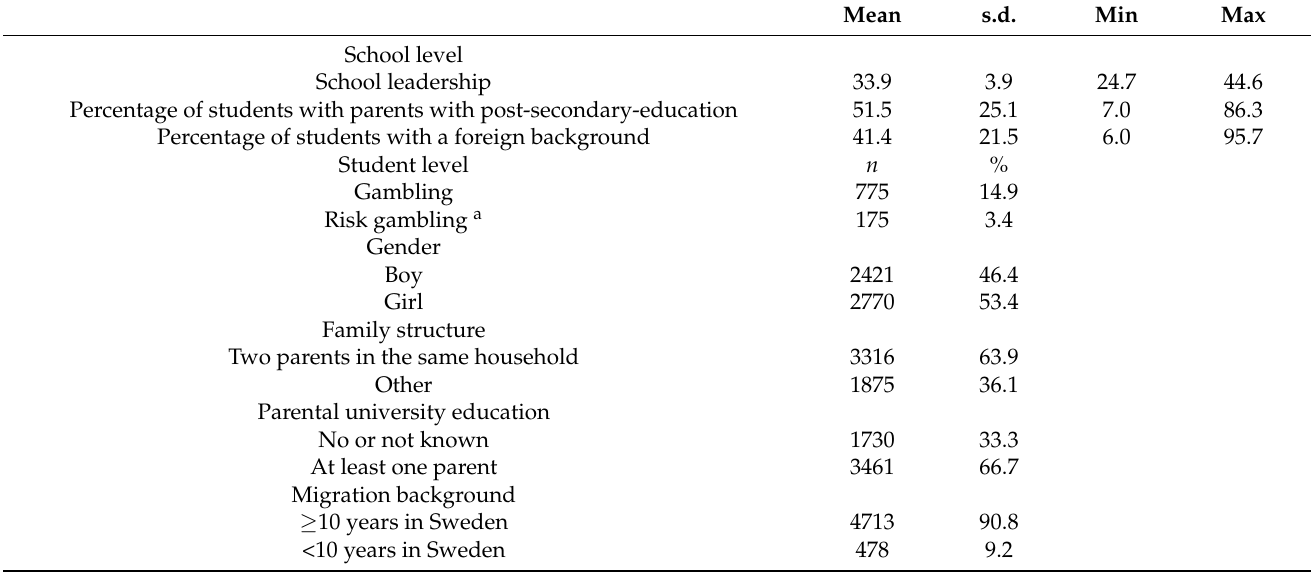
Table 1. Descriptive statistics ( n = 5191 students in 46 upper secondary